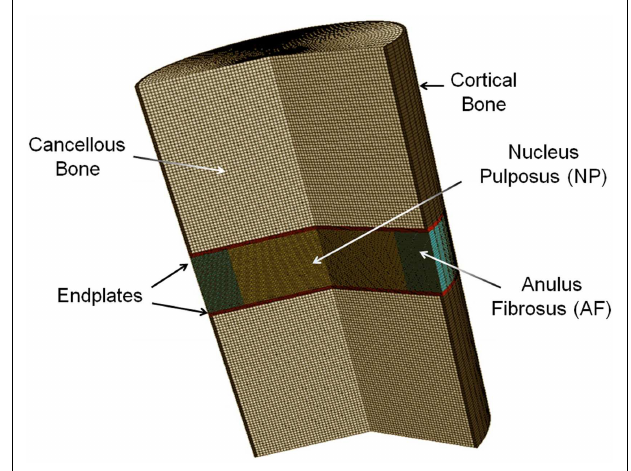
FIGURE 1 | Revolved axisymmetric poroelastic FE model of porcine intervertebral disk .